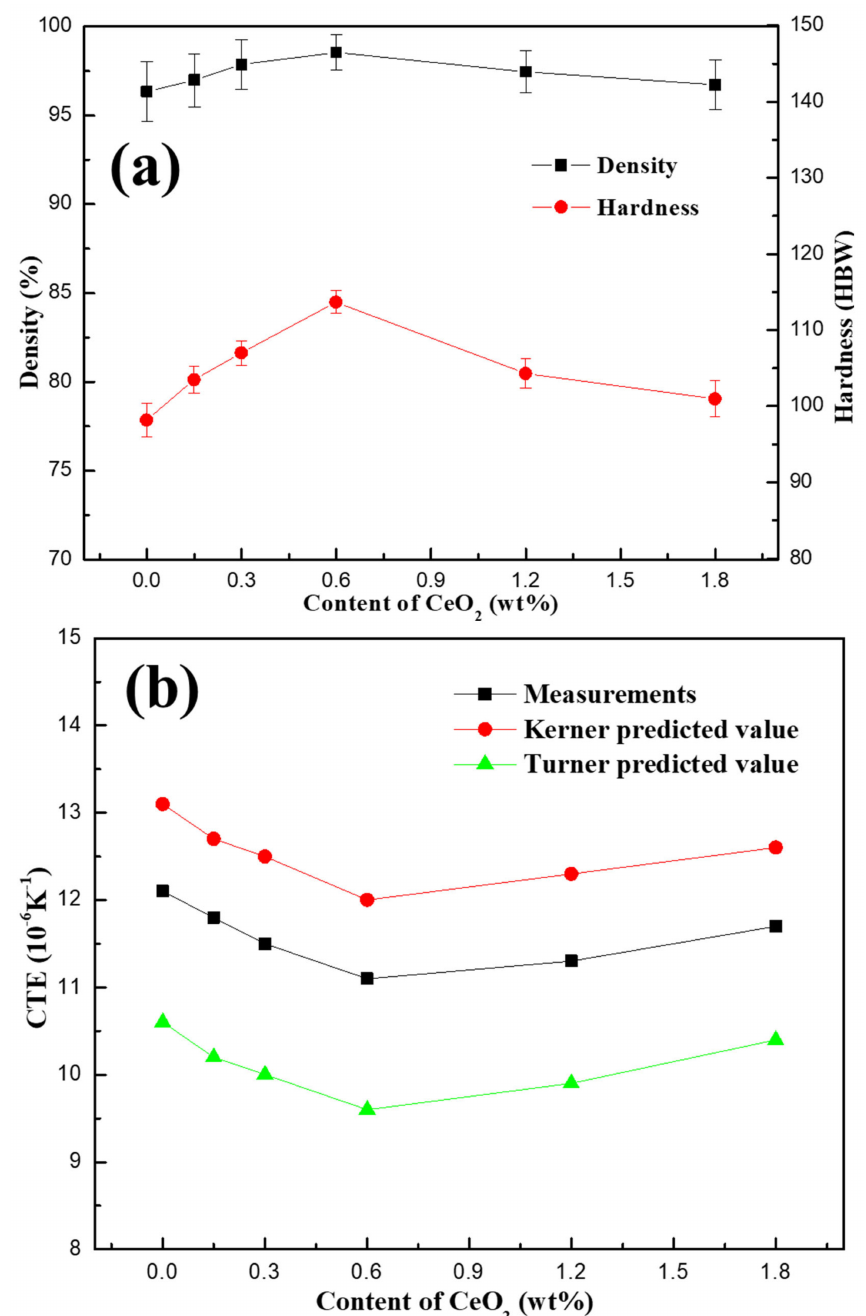
Figure 6. The density, Brinell hardness and coe ffi cient of thermal expansion (CTE) of SiCp / Al-Si Composites with di ff erent CeO 2 contents: ( a ) density and hardness; ( b )